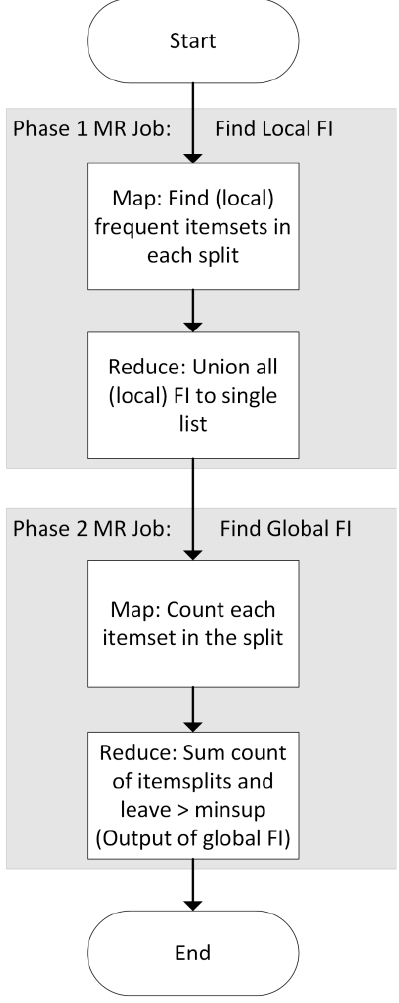
Figure 3. MRApriori and IMRApriori Block Diagram.